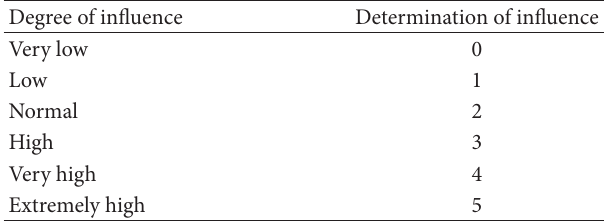
Table 2: Degree of influence.